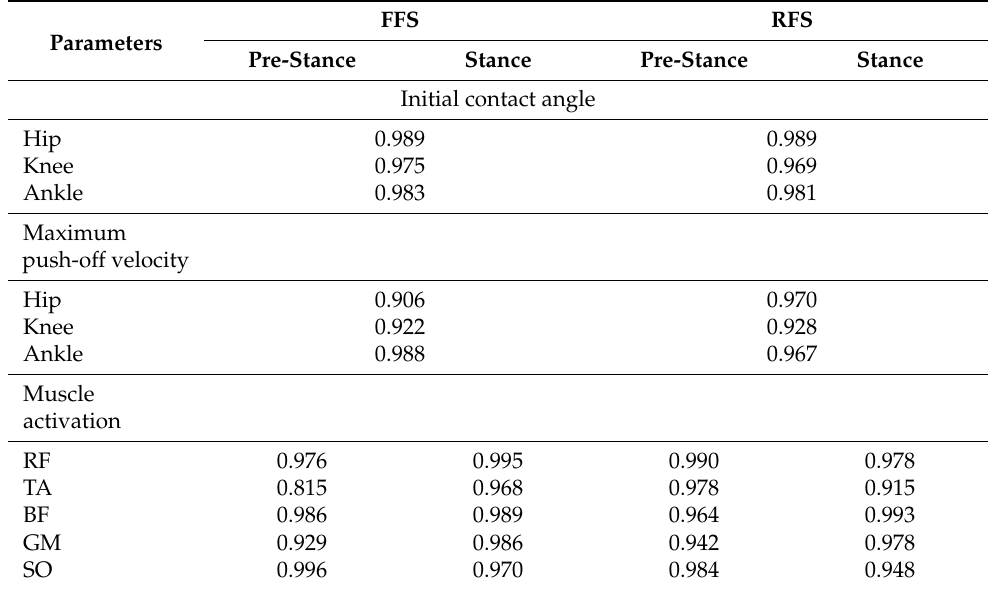
Table 1. The intraclass correlation coefficient of joint kinematics and muscle activation during stance phase.